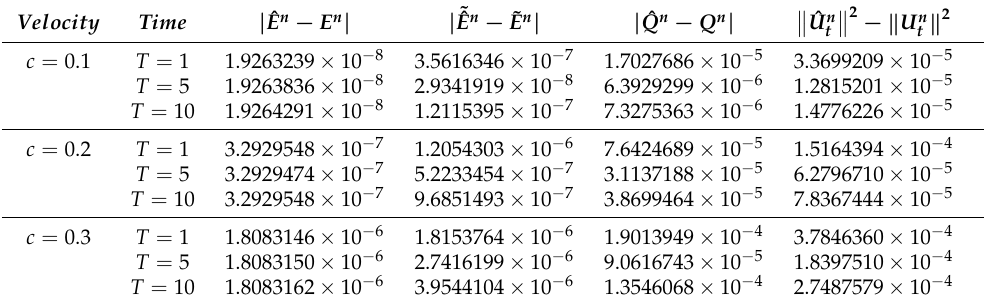
Table 4. The errors between exact and approximate discrete energies and quantities with different velocities at different